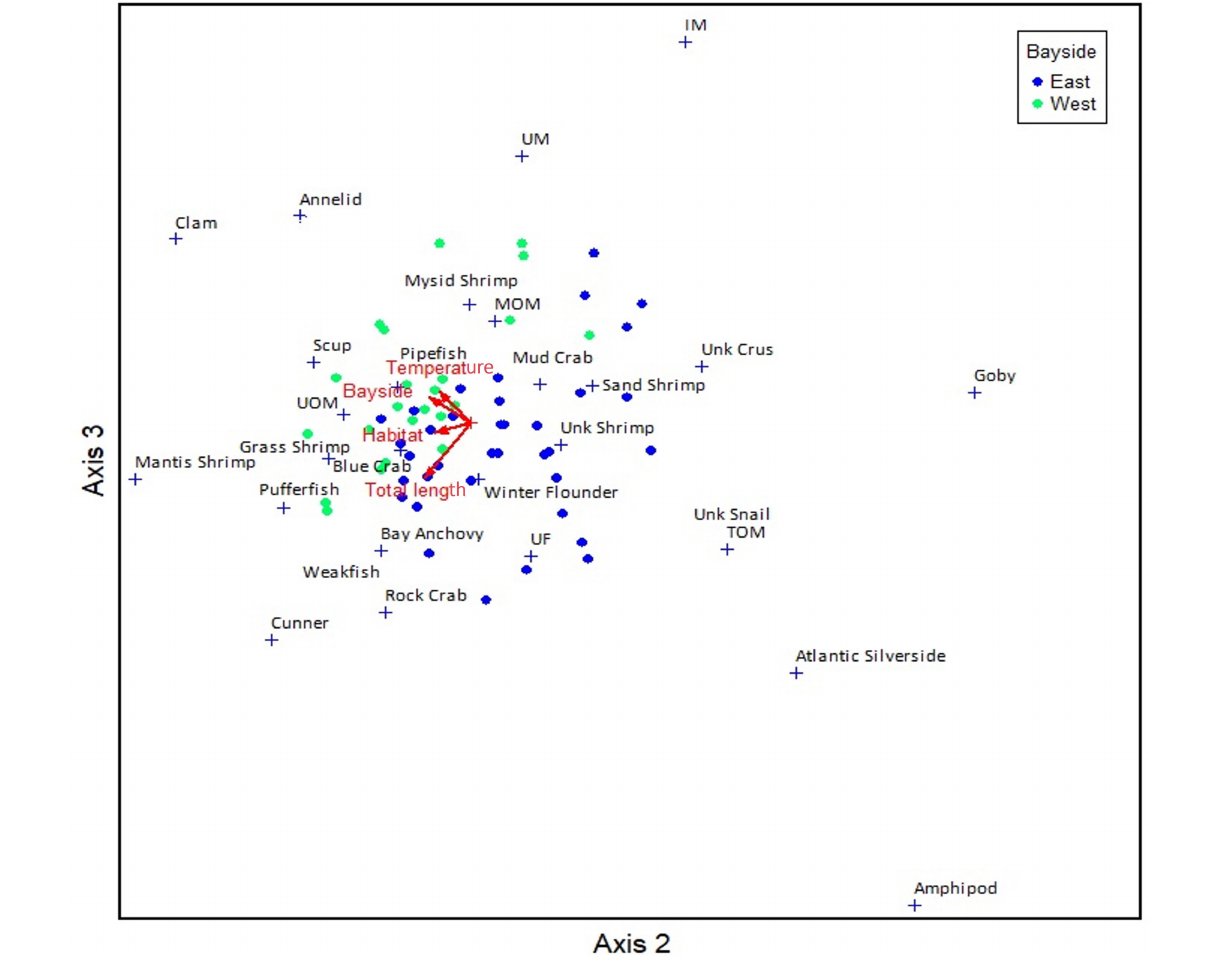
accounting for 7.6% (SD ± 3.7%) of the diet by weight with an O% of